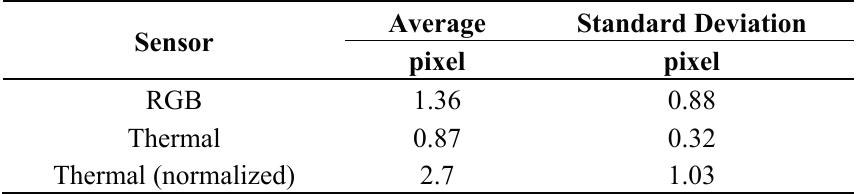
Table 2. Error comparison between manual and automatically ACPs